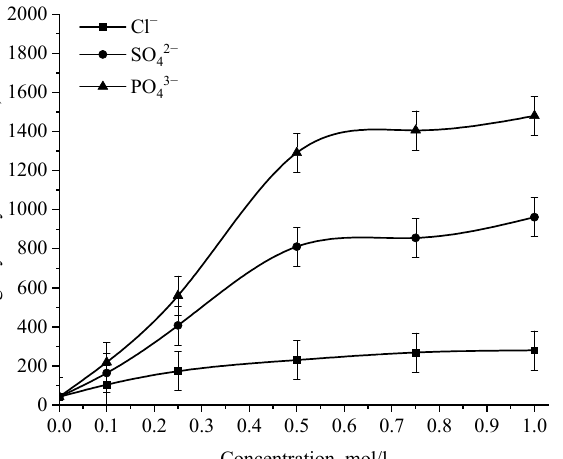
Figure 15. Dependence of the average hydrodynamic radius of Se NPs in positive sol on the concen- tration of various ions.